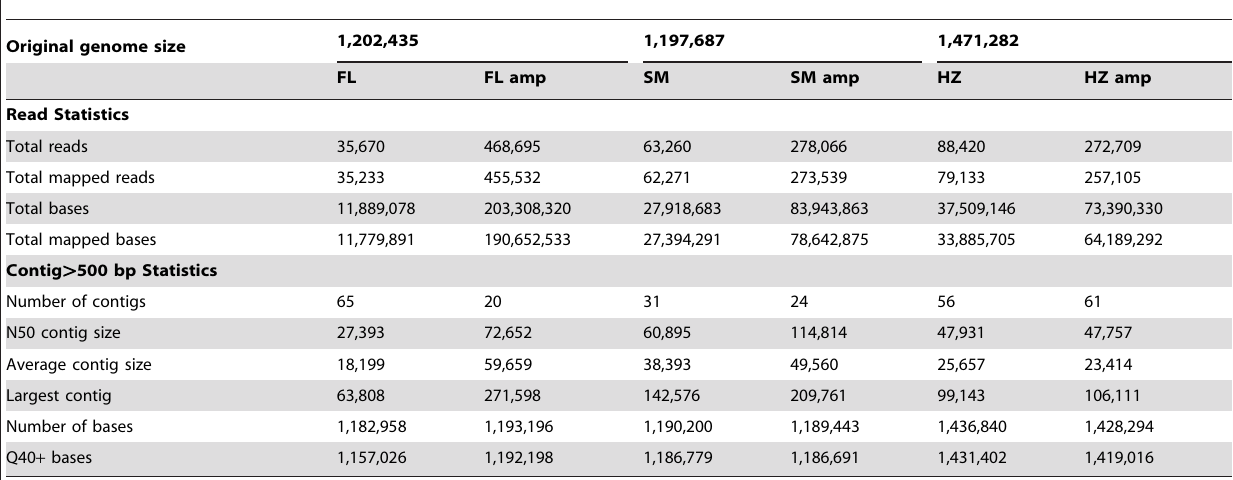
Table 1. Genomic sequencing